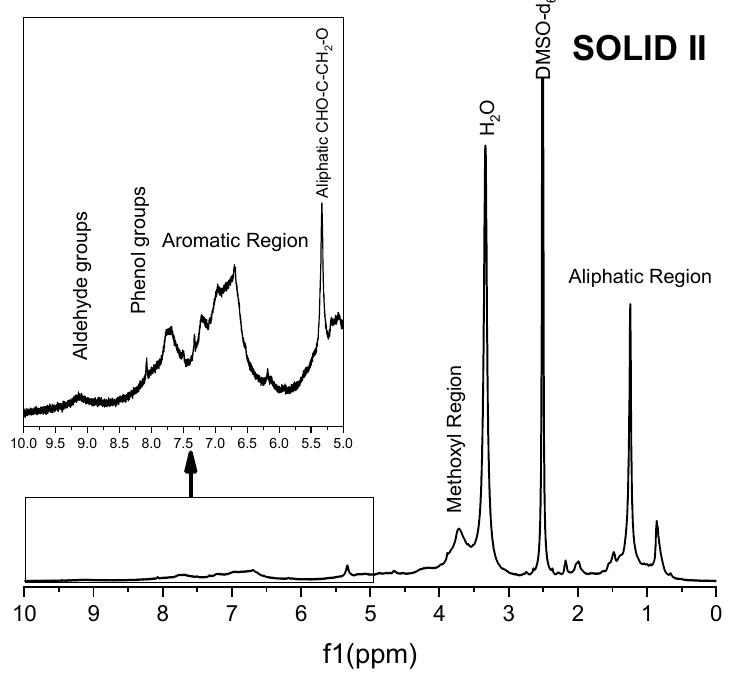
Appl. Sci. 2019 , 9 , x FOR PEER REVIEW